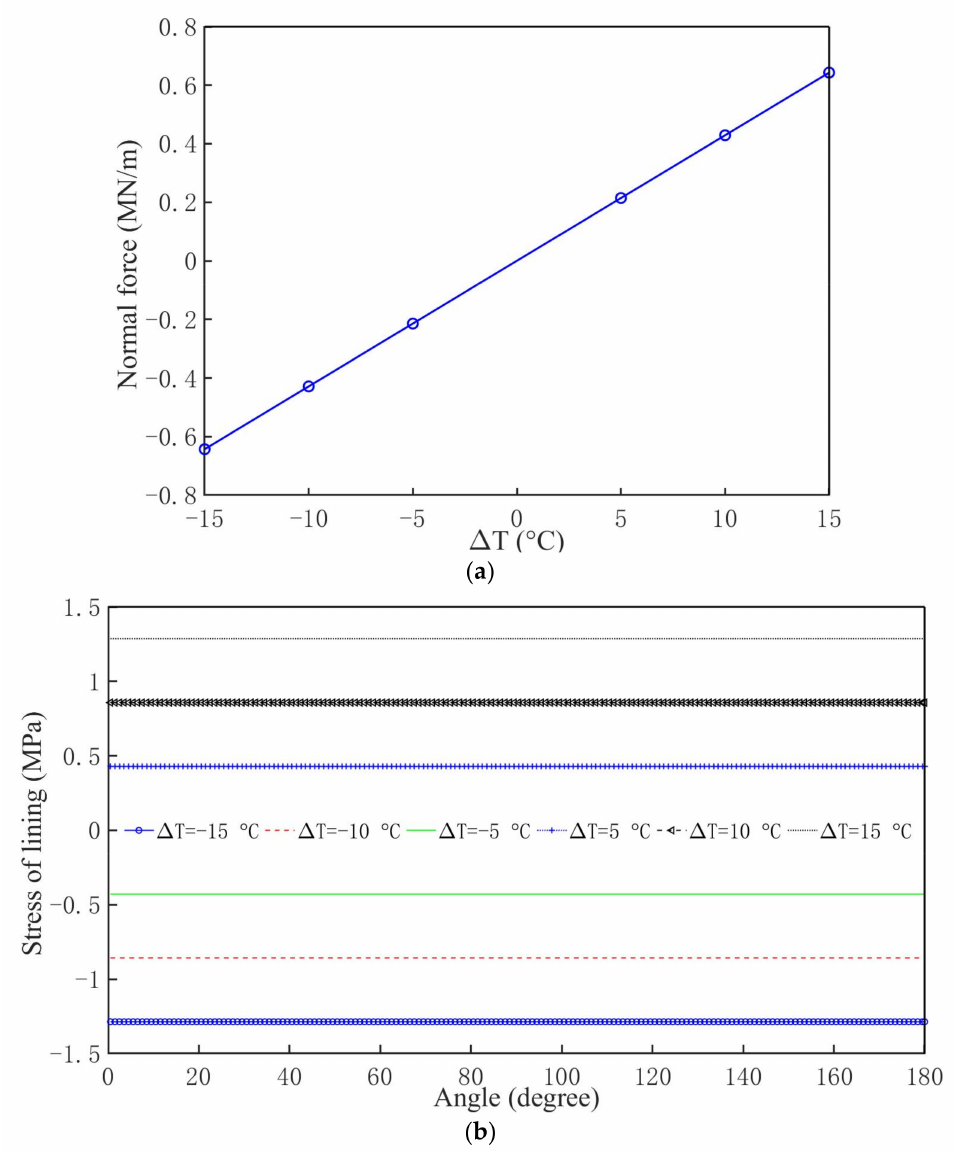
Figure 5. Effect of ∆ T on the internal forces of tunnel lining when considering both σ Ts and σ Tl : ( a ) Normal force; ( b ) Stress of